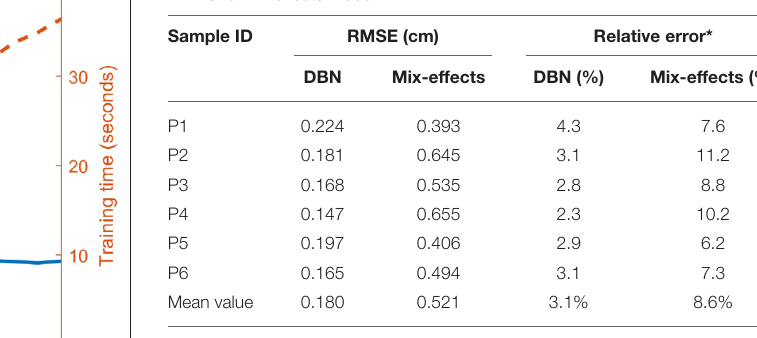
TABLE 3 | The absolute and relative prediction errors of 6 testing samples under DBN and Mix-effects